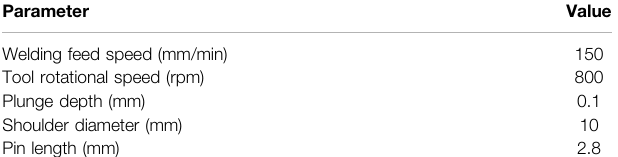
TABLE 2 | Welding process parameters of tailor welded